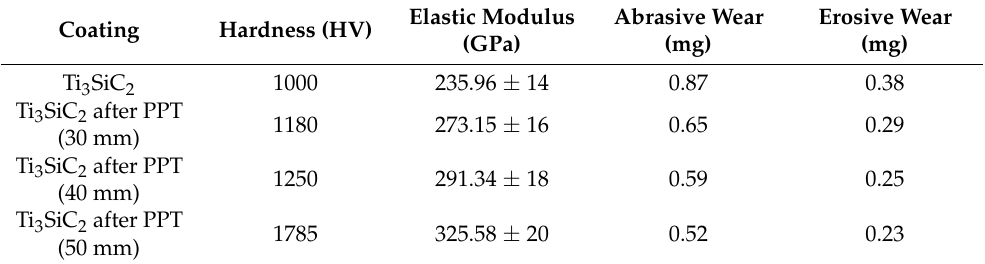
Table 1. Mechanical properties of